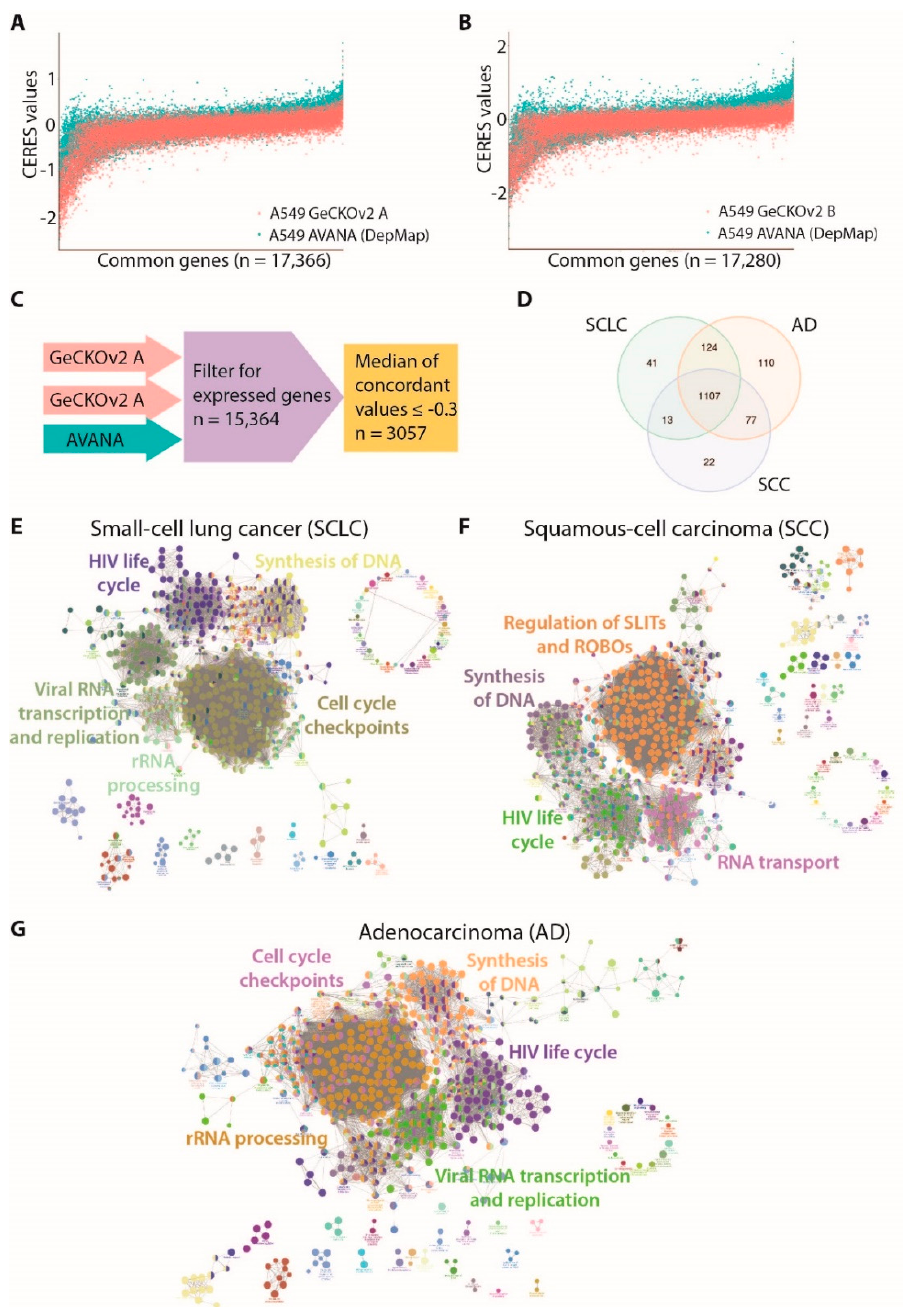
Figure 2. Identification of genes and pathways essential for lung cancer main histotypes: ( A ) comparison of CERES scores along all common genes between AVANA library (DepMap) and GeCKOv2 sub-library A in A549 cells; ( B ) comparison of CERES scores along all common genes between AVANA library (DepMap) and GeCKOv2 sub-library B in A549 cells; ( C ) schematic representation of filtering strategy used to identify the A549 dependency genes; ( D ) Venn diagram summarizing the number of genes whose CERES score resulted ≤− 0.3 (D threshold) in at least 90% of cell lines for each histotype (AD: adenocarcinoma; SCLC: small-cell lung cancer; SCC: squamous-cell carcinoma; ( E ) network representation of significantly enriched pathways for the SCLC dependency gene set (n = 1285); ( F ) network representation of significantly enriched pathways for the SCC dependency gene set (n = 1219); ( G ) network representation of significantly enriched pathways for the AD dependency genes set (n = 1418).